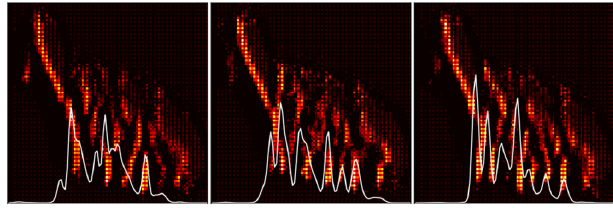
FIG. 4. SetMedium Saliency Map of the first convolutional layer. We use the SetMedium training model for the three example simulations.